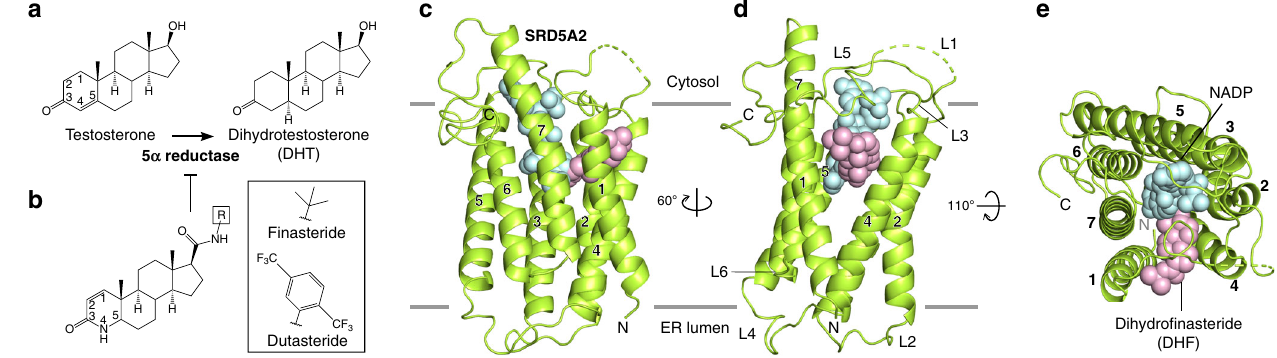
Fig. 1 Overall structure of human SRD5A2. a 5 α -reduction reaction of the Δ 4,5 double bond of testosterone catalyzed by SRD5A2 to generate dihydrotestosterone (DHT). b SRD5A2 inhibition by fi nasteride and dutasteride. The two inhibitors share the same ring structure with different R-groups connected to the amide side chains. c – e Three views of the SRD5A2 structure. The NADP – DHF adduct was shown as spheres. L1 – 6 represent six loops connecting 7-TMs. The NADP and DHF moieties were colored in light cyan and light pink,